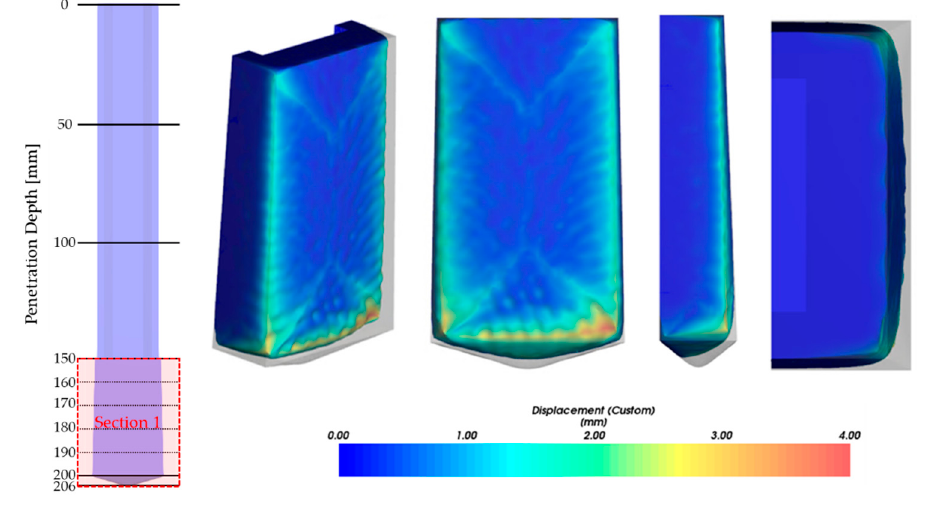
Figure 11. Worn displacement on Section 1.